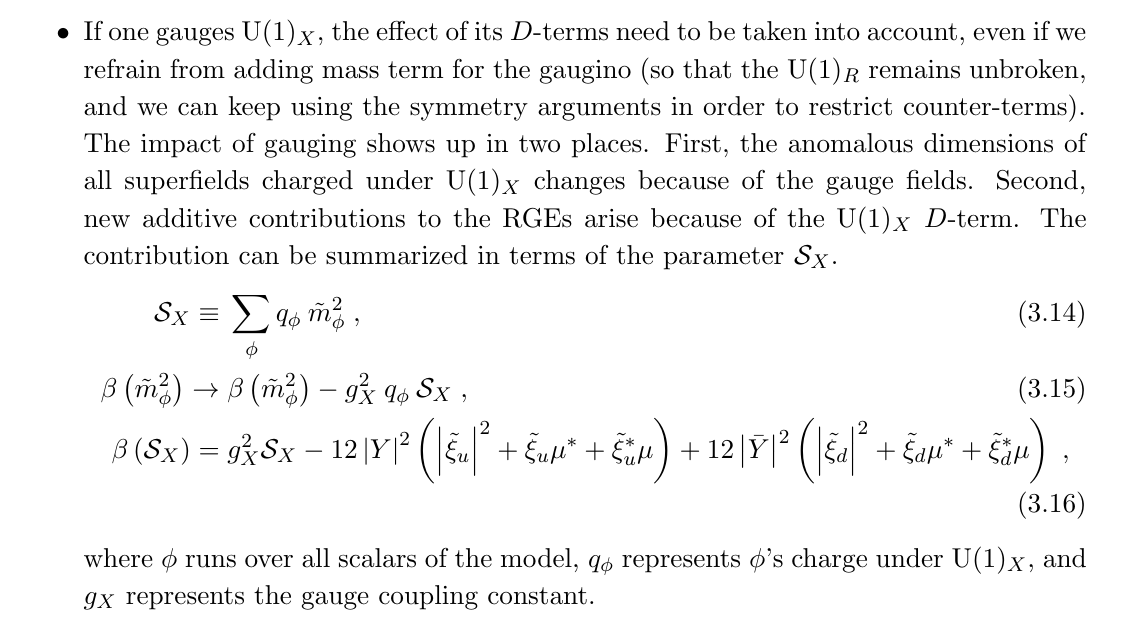
~ q ~ u because of the presence of (cid:22) Y d